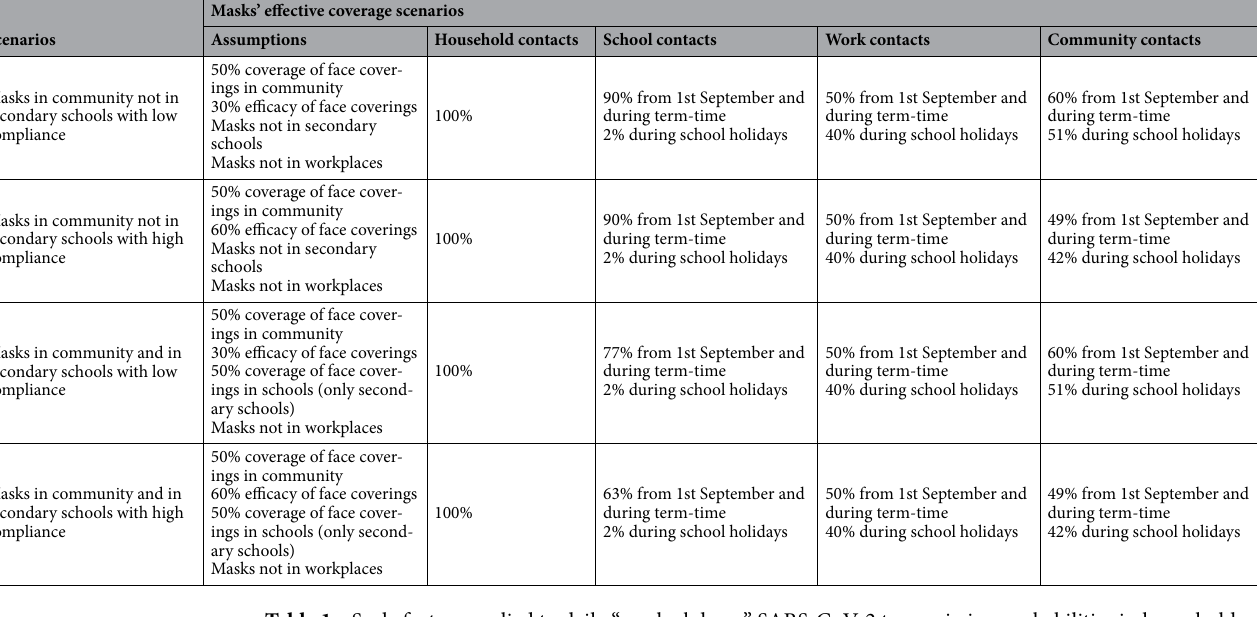
Table 1. Scale factors applied to daily “pre-lockdown” SARS-CoV-2 transmission probabilities in households, schools, workplaces from September 2020, and the community under the scenarios of face coverings policy and compliance levels. Scale factors applied prior to September 2020 are the same across all scenarios and are summarised in Table S4.